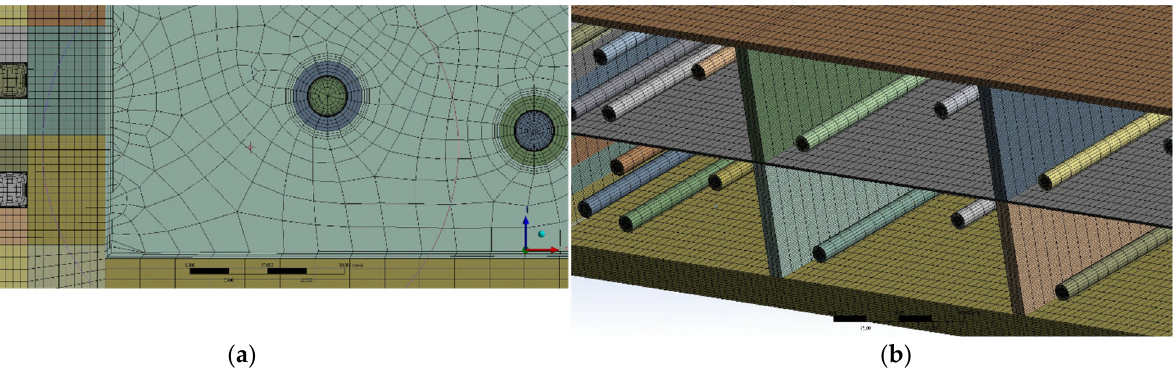
Figure 4. Mesh details. ( a ) Inflation layers in the water and PbLi domain. ( b ) Schematic of the internal structured grid.